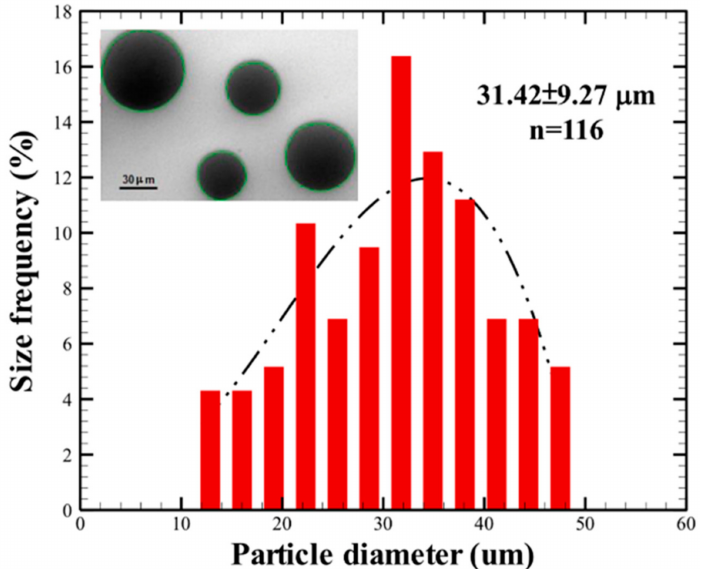
Figure 1. Optical microscope image and the particle size distribution of Ti64 powder. The mean particle size of the Ti64 powders determined using ImageJ was 31.42 ± 9.27 µ m ( n = 116).